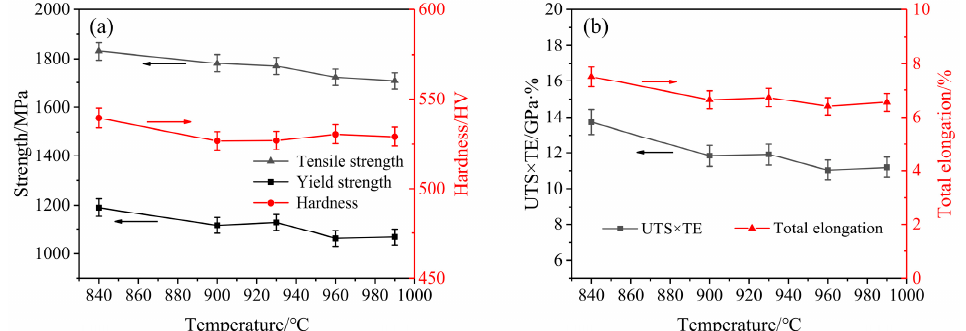
Figure 9. The variation of the mechanical properties after different austenitizing temperatures: ( a ) Strength varies with temperature, ( b ) Strength-ductility product and total elongation vary with temperature.